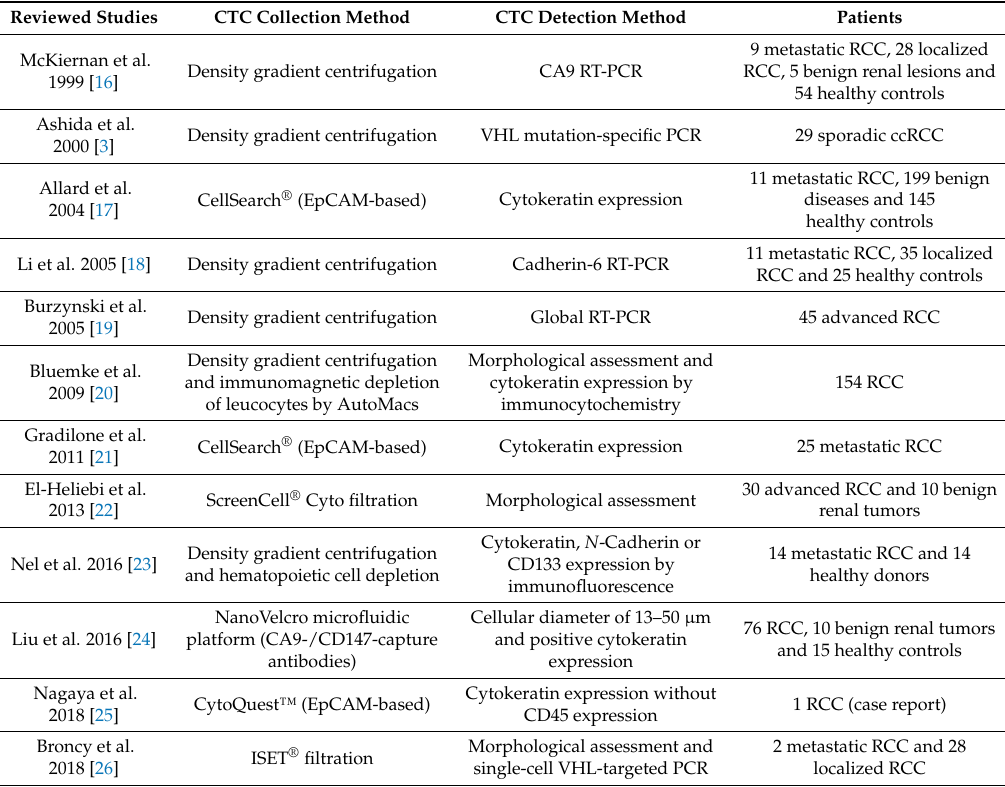
Table 1. Selected studies on circulating tumor cells in renal cell carcinoma